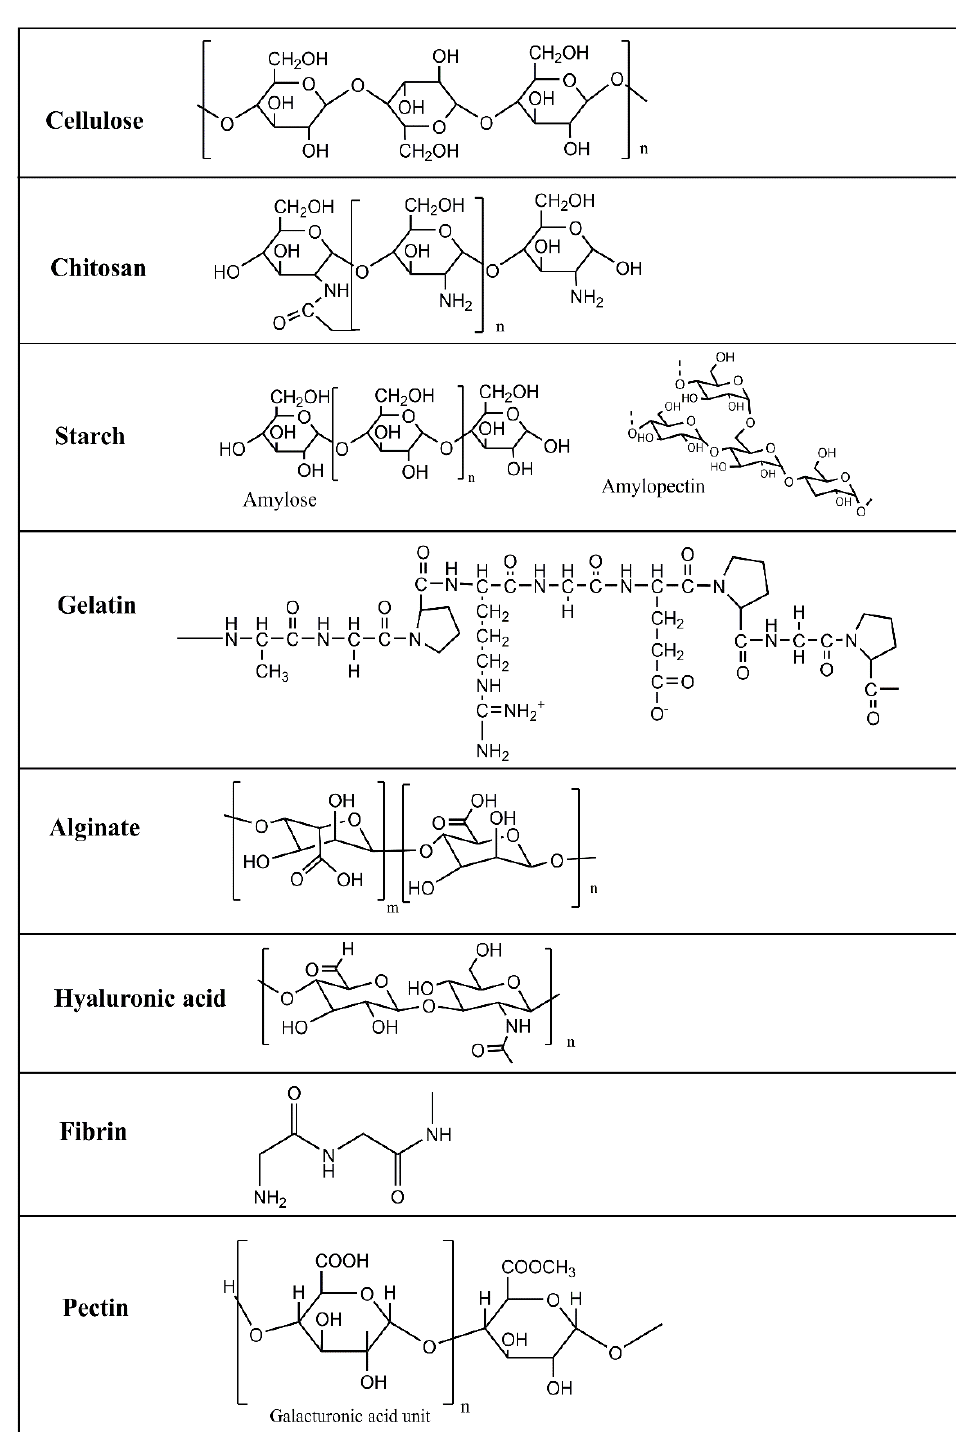
Figure 2. Chemical structure of